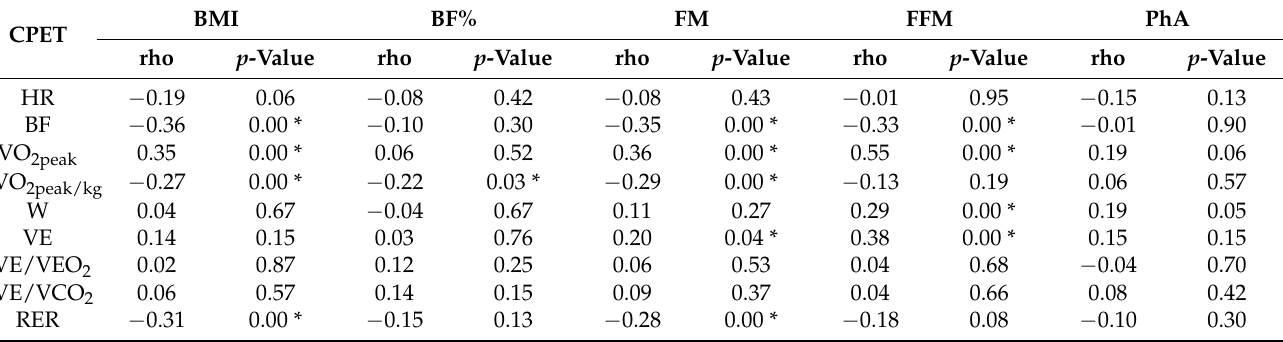
Table 7. Spearman correlation between various parameters of body mass composition and capacity